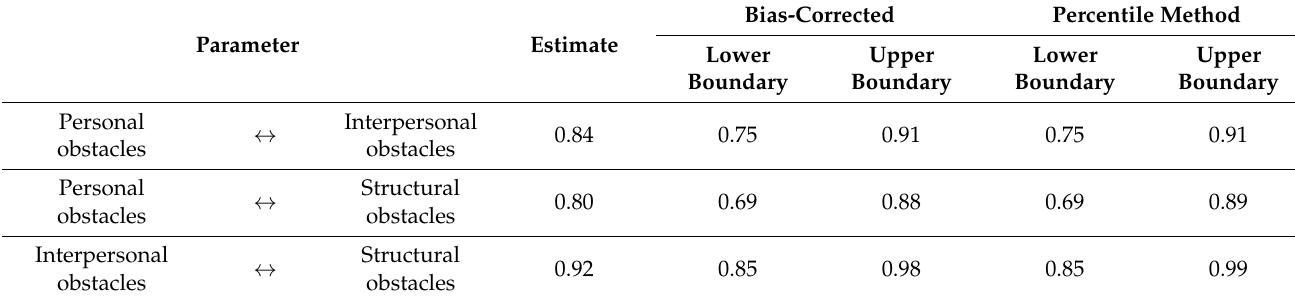
Table 5. Leisure hindrance—bootstrap 95% confidence interval table of related coefficients.